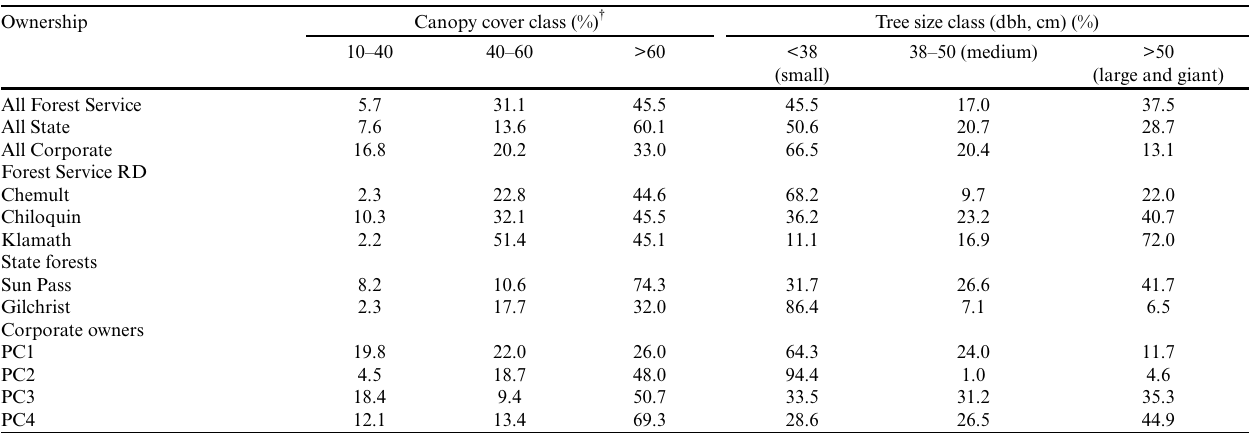
Table 6. Current forest structure conditions by ownership